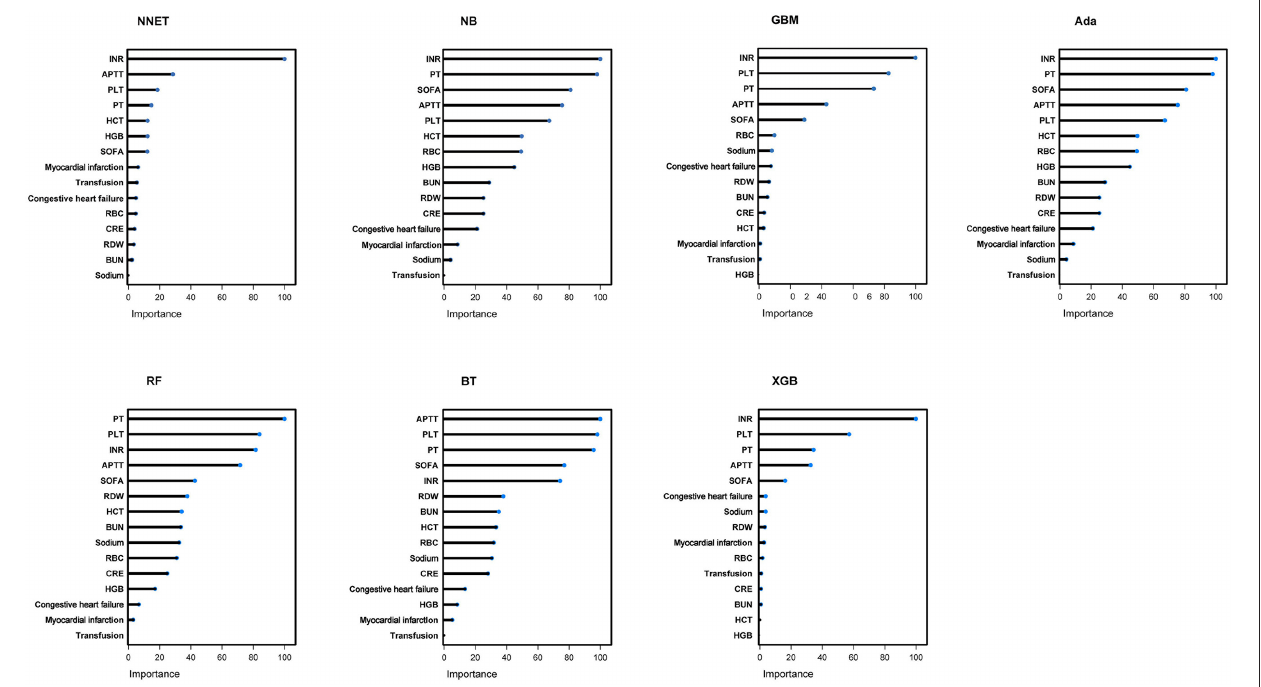
FIGURE 5 | Variable importance in seven different ML models. ML, machine learning; NNET, artificial neural network; NB, naïve bayes; GBM, gradient boosting machine; Ada, adapting boosting; RF, random forest; BT, bagged trees; XGB, eXtreme Gradient Boosting; INR, international normalized ratio; PT, prothrombin time; SOFA, sepsis related organ failure assessment; APTT, activated partial thromboplastin time; PLT, platelet; HCT, hematocrit; RBC, red blood cell; HGB, hemoglobin; BUN, blood urea nitrogen; RDW, red blood cell volume distribution width; CRE,